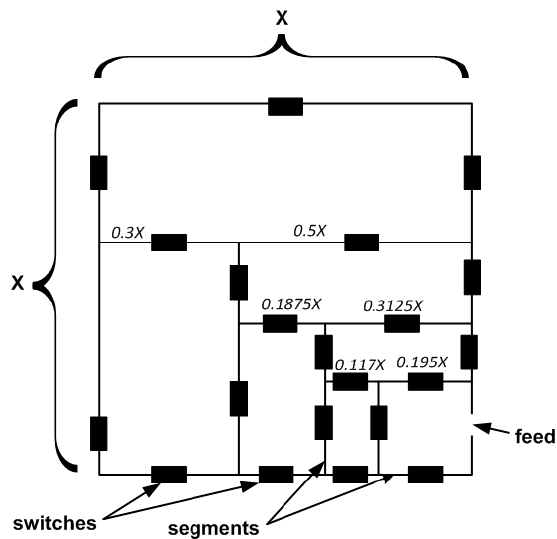
Figure 1. Antenna template.